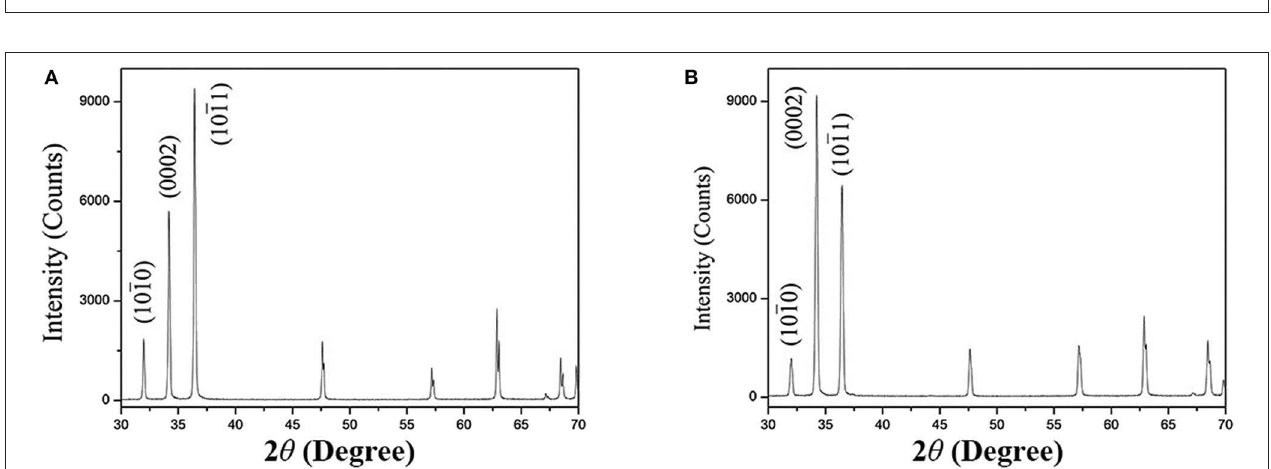
FIGURE 1 | Schematic diagrams of (A) tensile and (B) compressive samples machined from as-extruded profiles.